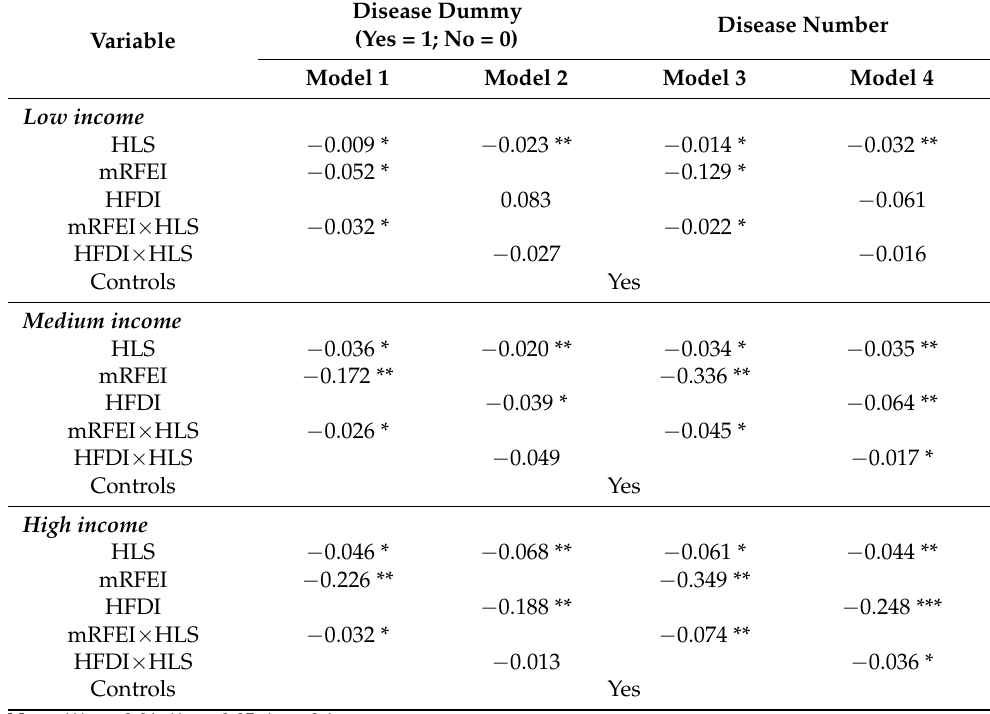
Table 6. Heterogeneity effect of food environment by